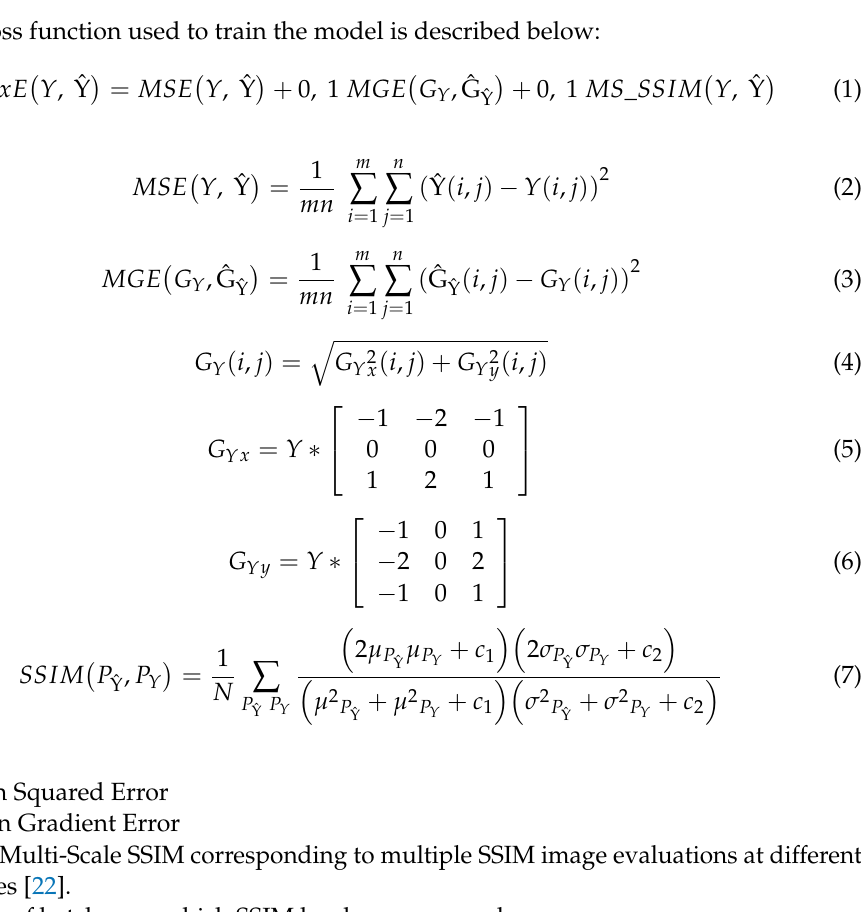
Figure 1. Deep learning model